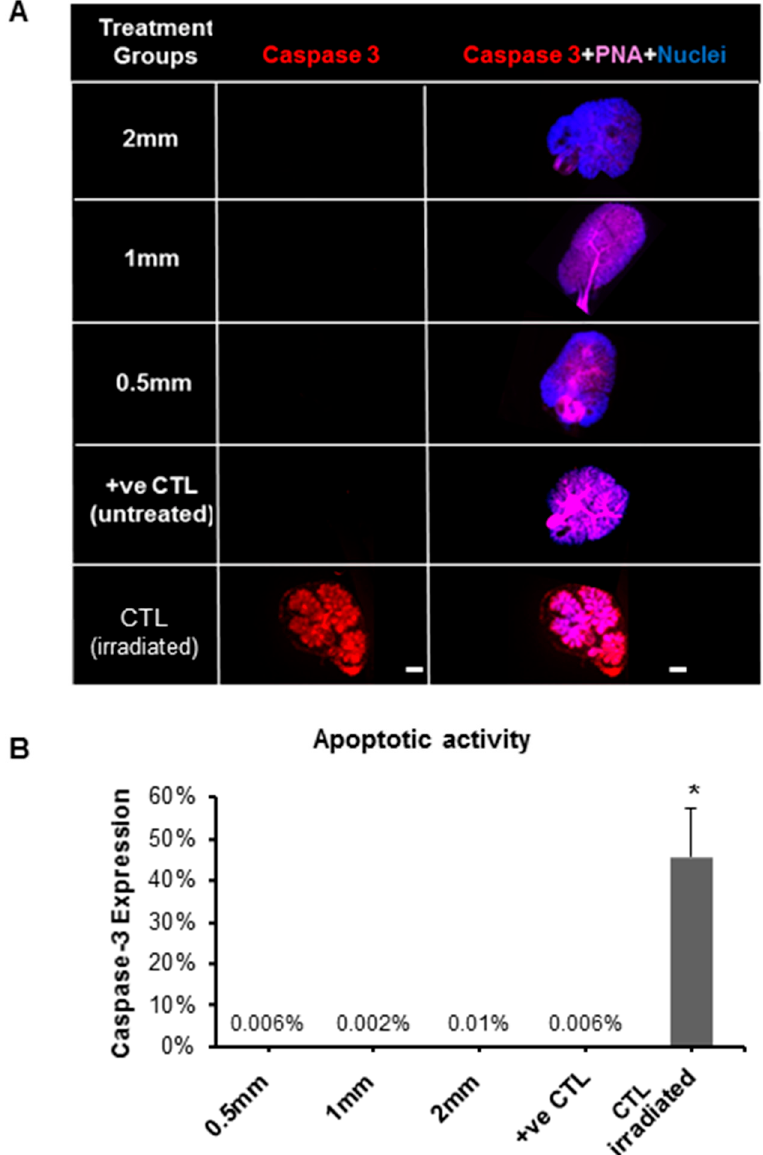
Figure 5. Expression of apoptotic protein marker (Caspase ‐ 3) in SG after treatment with pilocarpine nanofiber mats after five culture days in the ex vivo SG model. ( A ) Fluorescence imaging after whole gland immunofluorescence staining showing expression of Caspase-3 in red (apoptotic marker), PNA in pink (staining the gland epithelial acini and ductal branched network) and nuclei in blue. ( B ) Apoptotic activity by quantification of Caspase-3 fluorescence after normalizing with nuclear counts. Error bars represent SD from n = 4. * p < 0.05 when compared to positive control. Positive control (+ve CTL) was not treated with nanofiber mat and only had growth media. CTL (irradiated): gamma radiation treatment was used as a control for Caspase-3 staining since it induces apoptotic damage to the gland.